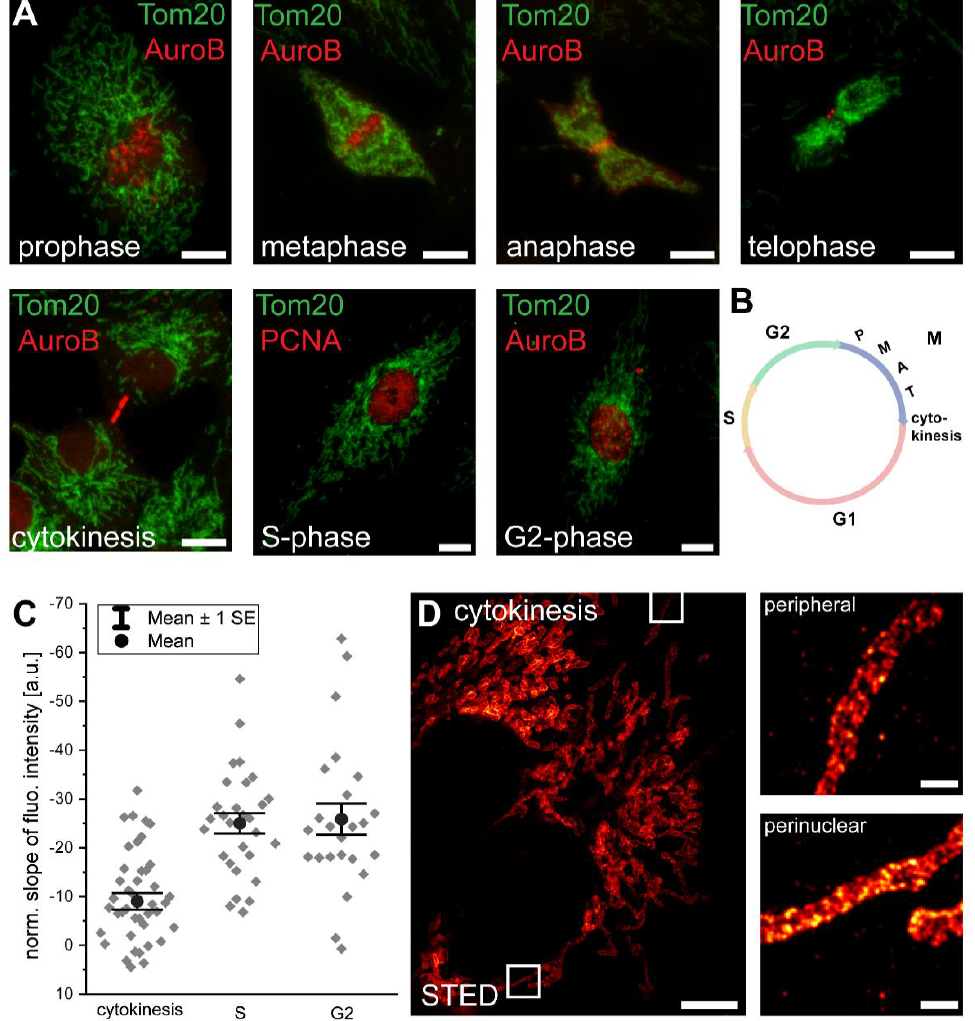
Figure 2. Immediately after mitosis, a Tom20 abundance gradient is generated. ( A ) In a non-synchronized cell culture, cell-cycle stages were assigned using antisera against Aurora B kinase and PCNA. ( B ) Schematic of the cell cycle. ( C ) Analysis of the normalized slopes of the Tom20 fluorescence intensity gradients of cells at cytokinesis, S-phase, or G2-phase. Overlapping mitochondria were excluded from the analysis. Each grey rhomb represents one cell. Black circle: mean. Error bars: standard error of the mean. ( D ) STED microscopy of a cell at cytokinesis, labeled with antiserum against Tom20. Small images are magnifications of perinuclear or peripheral mitochondria as indicated by rectangles in the overview image. Scale bars: 0.5 µm ( D : magnifications), 5 µm ( D : overview), 10 µm ( A ).